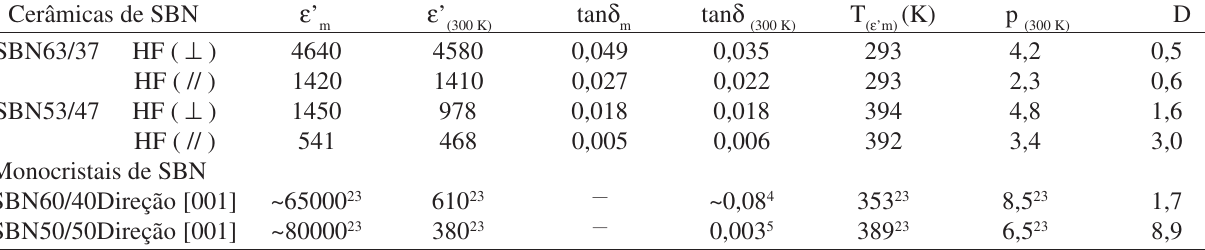
Tabela 2. Valores representativos de permissividade elétrica ( ε ’) e perdas dielétricas (tan δ ) no valor de máximo (subíndice m) e em 300 K, temperatura do máximo de permissividade (T detetividade em unidades de ( × 10 -5 C/m 3/2 J 1/2 ).